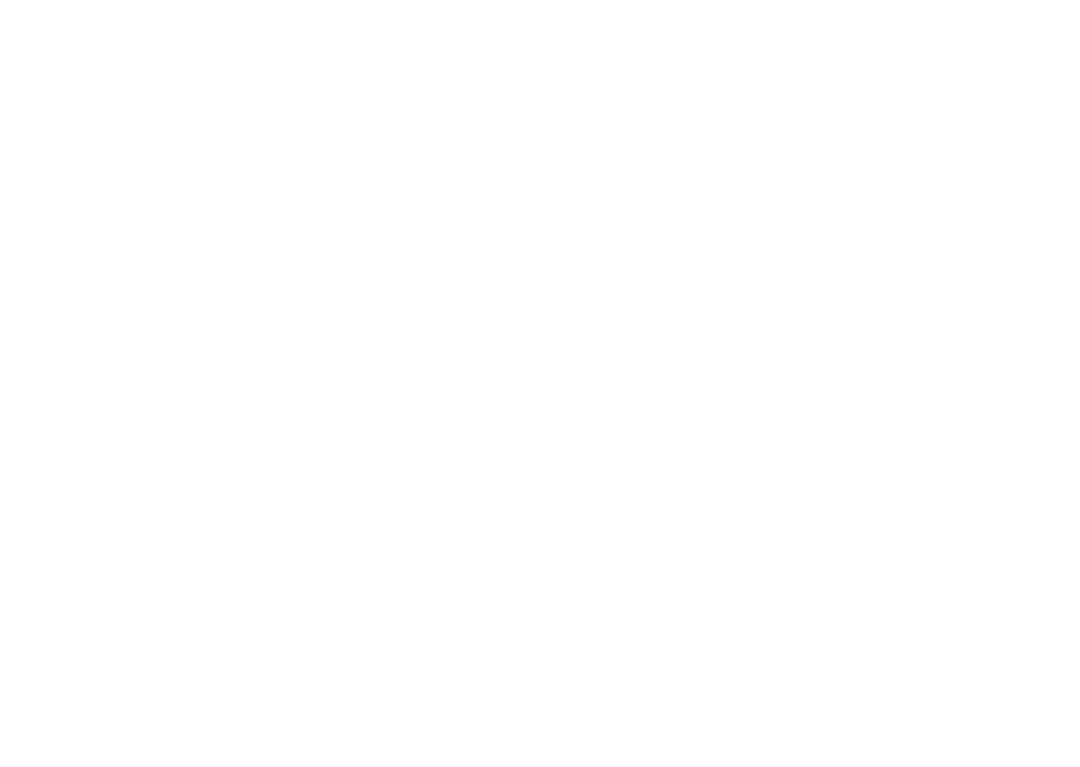
Algorithm 2 Multi-layered security model using PUF: Client is an existing User